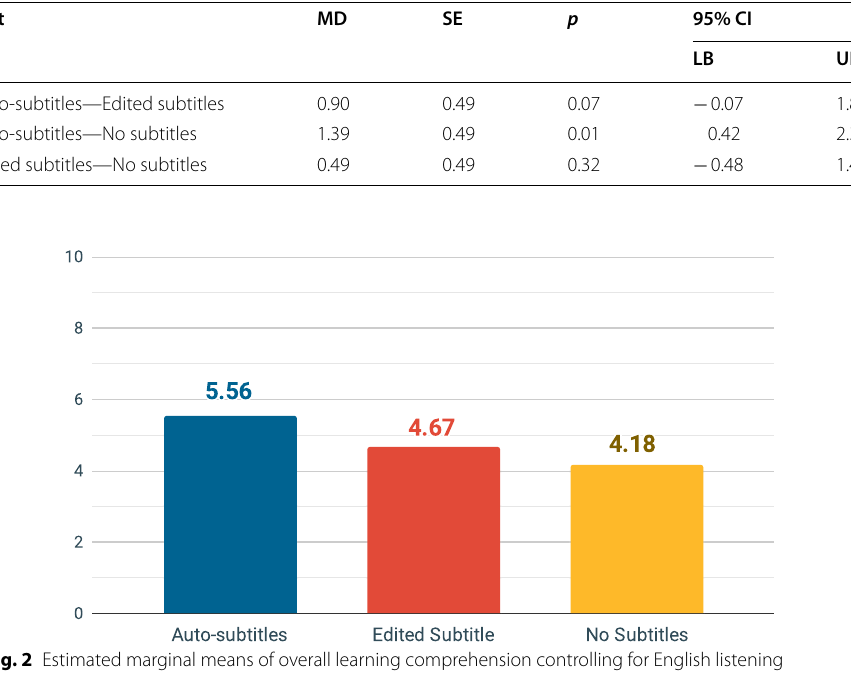
Table 4 Pairwise comparisons of learning comprehension